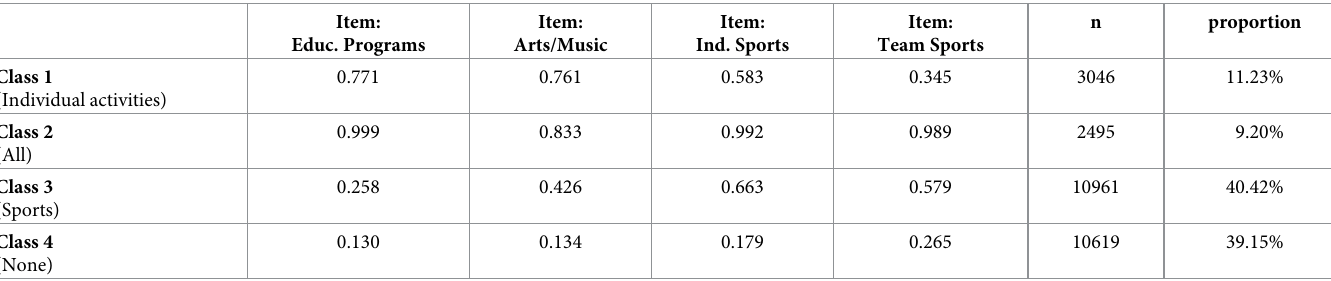
Table 2. Latent class prevalence and item response probabilities for extracurricular activity